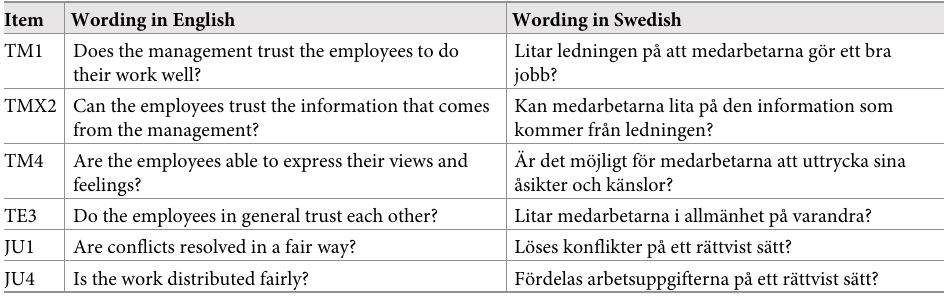
Table 2. Overview of items (variable name refers to international COPSOQ III nomenclature